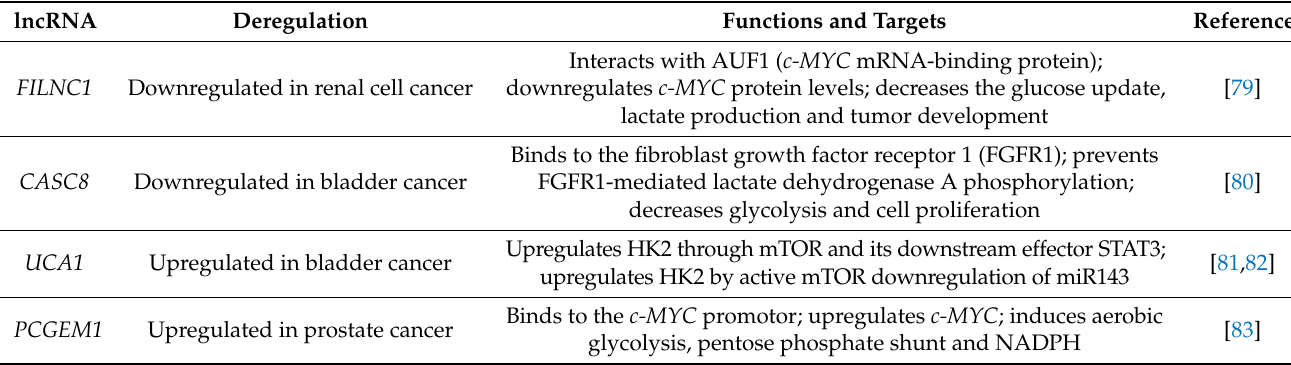
Table 2. Examples of lncRNAs implicated in glucose metabolism alteration in GU